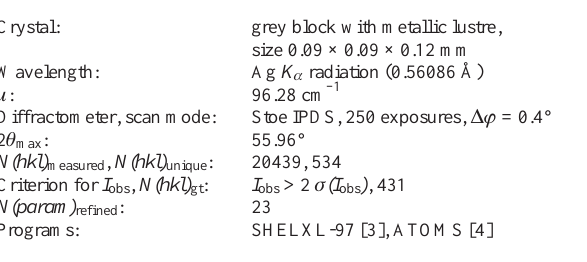
Table 1. Data collection and